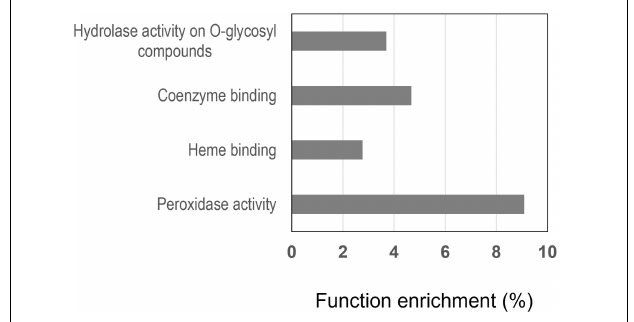
FIGURE 8 | Molecular functions most enriched in the 196 genes in R108 responding to nitrate by both their transcript and protein. The enrichment, expressed in percent, was determined by an agriGO